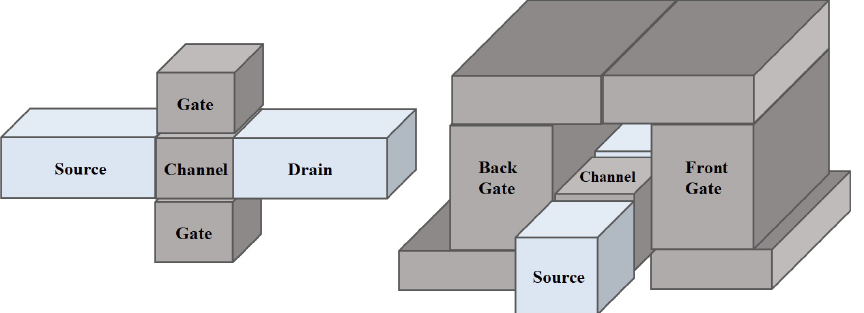
Figure 2. Three-dimensional fin structure of a transistor based on Han and Wang, 2013.